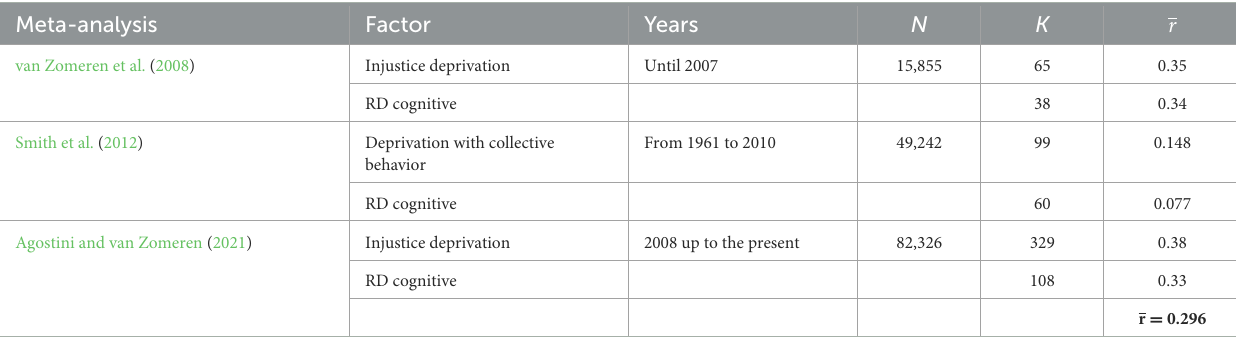
TABLE 3 Relationship of relative deprivation and injustice with SM and